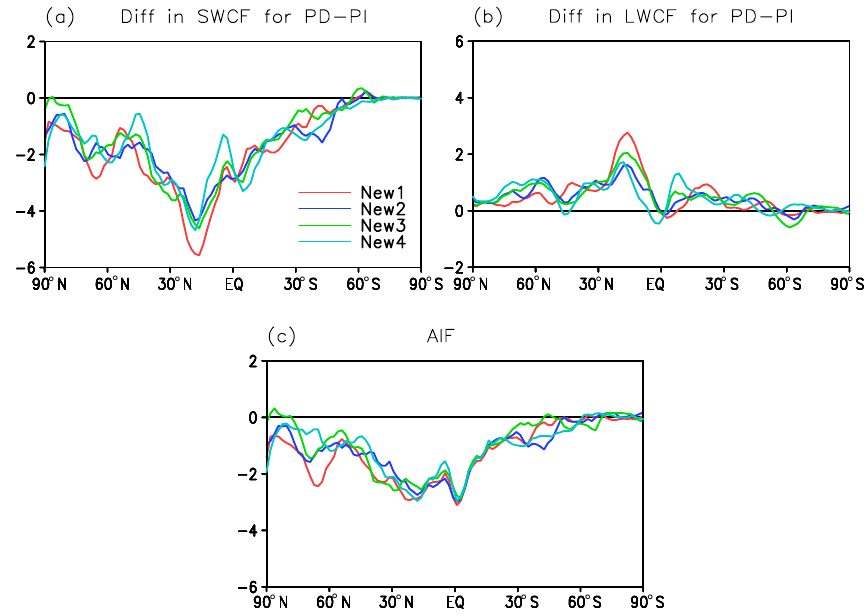
Figure 9. Annual, JJA, and DJF zonal mean differences in shortwave (SWCF, Wm − 2 ) and longwave cloud radiative forcing (LWCF, Wm − 2 ) between PD and PI, as well as aerosol indirect forcing (AIF, Wm − 2 ) derived from